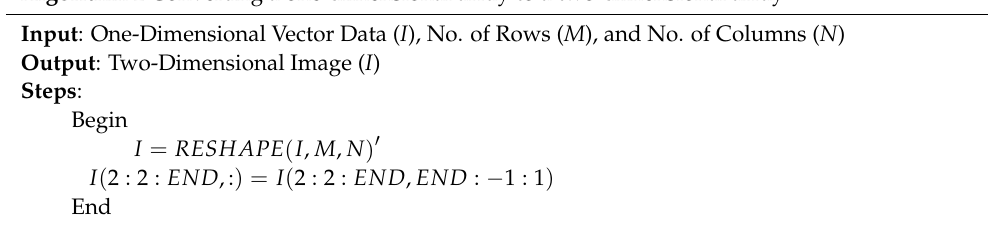
Algorithm 2 Converting a one-dimensional array to a two-dimensional array